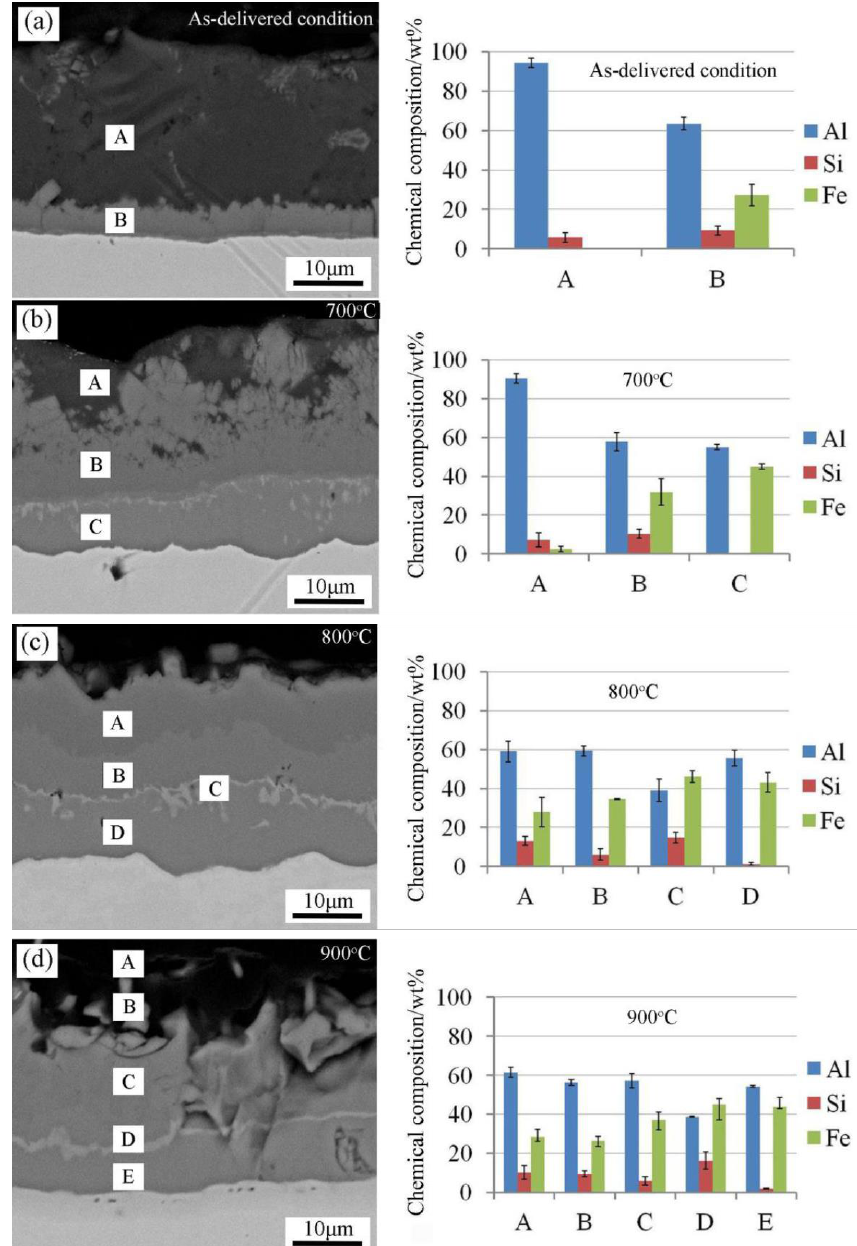
Figure 3. Morphology and chemical composition of the Al–Si coating heated at different temperatures: ( a ) as-delivered condition, ( b ) 700 °C, ( c ) 800 °C, and ( d ) 900 °C.